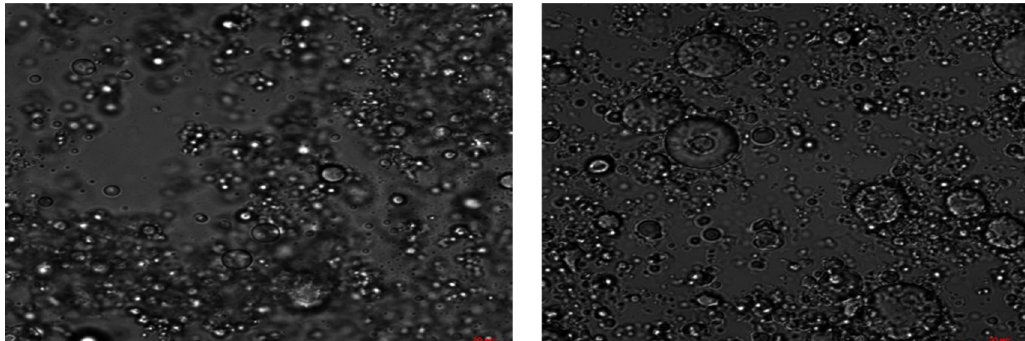
Figure 17. Confocal microscopic images of LSFE OB emulsion of non‐heated sample ( left T‐0, X63) and after 96 h of thermal heating (55 °C) ( right T‐96. X63).